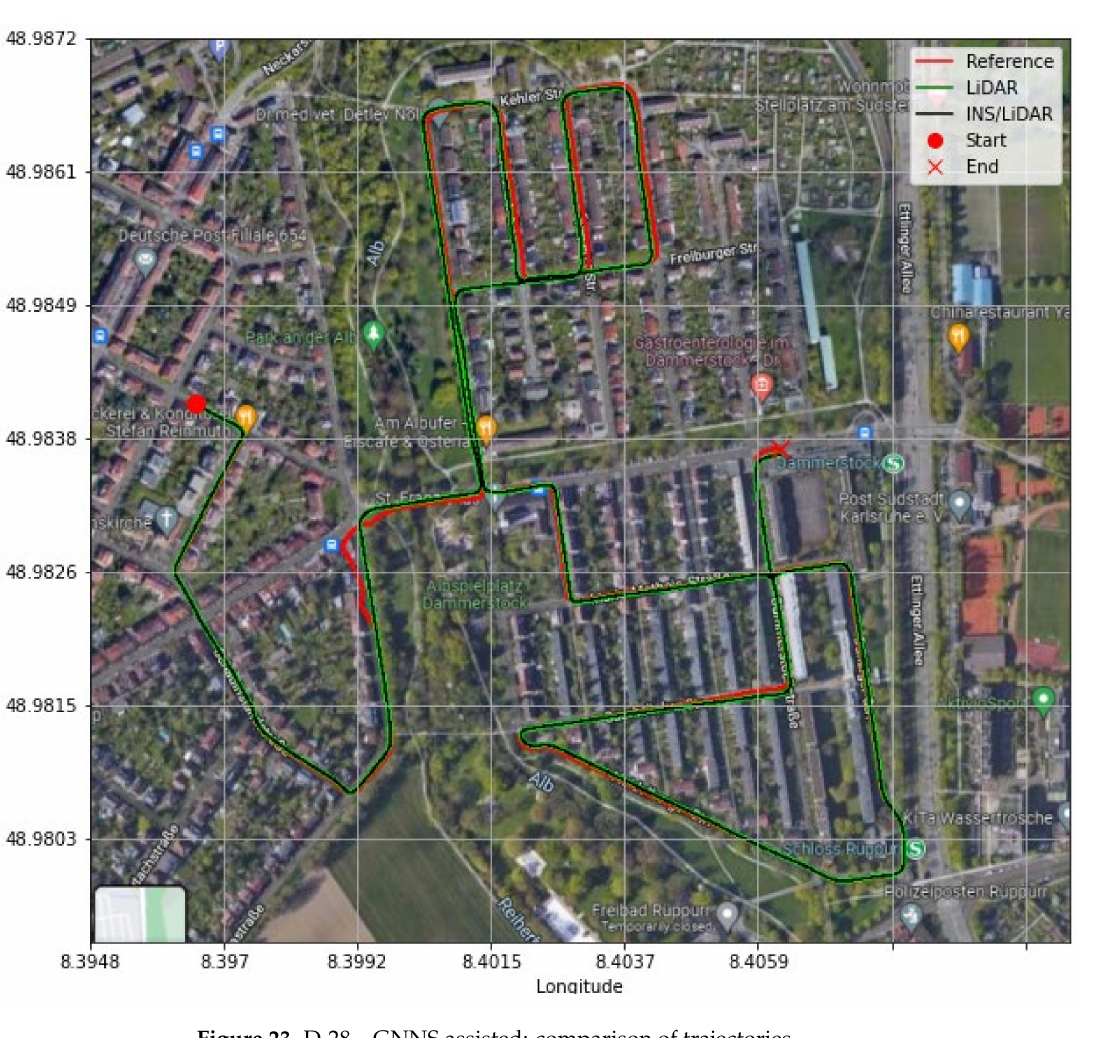
Figure 23. D-28—GNNS assisted: comparison of